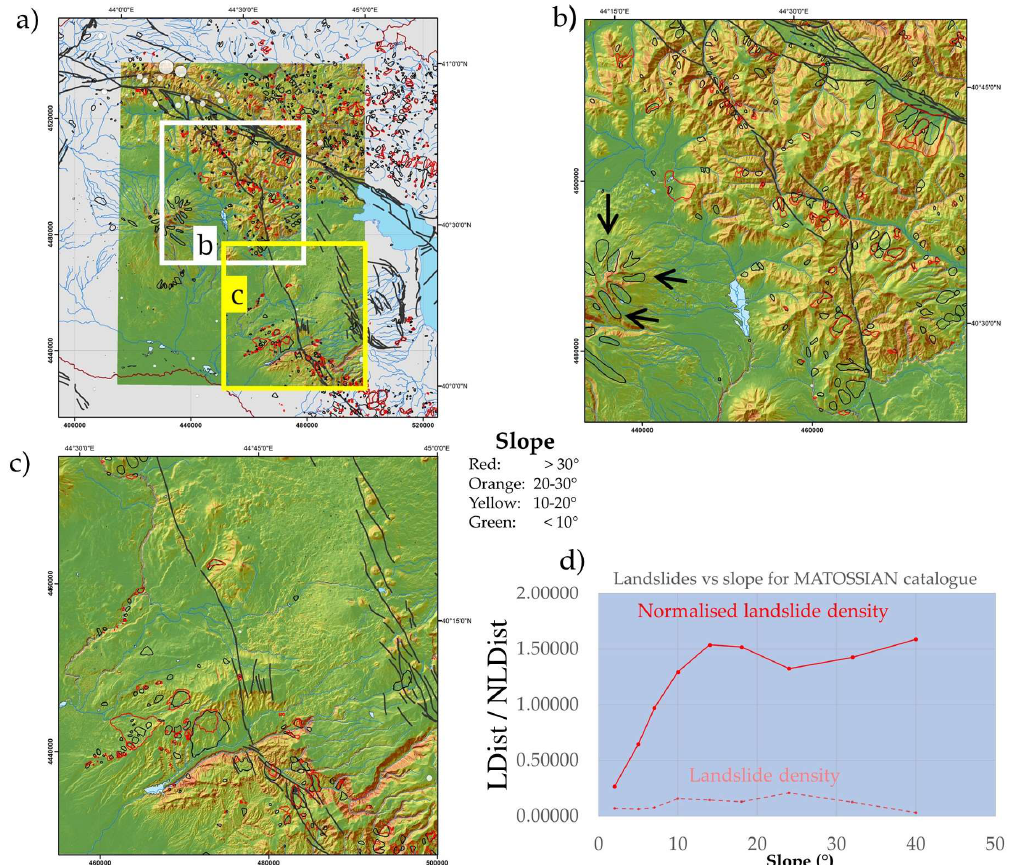
Figure 10. Landslide distribution with respect to local slope. ( a ) General map showing the locations of maps ( a ) and ( c ). ( b ) Enlarged view of the area to the east of Aragats volcano, showing the GF (west) and PSSF (east). Arrows mark zones atop Aragats where landslides recorded in the Georisk catalogue occur on very gentle slopes; these deposits are, instead, most likely of glacial origin. ( c ) Enlarged view of the area to the east of Yerevan, including part of the Ghegham volcanic ridge in the east. ( d ) Landslide density as a function of local slope. Landslide density represents the ratio of landslide areas within a certain slope class compared to the entire area covered by mass movements, whereas the normalized landslide density represents the same ratio normalized by the ratio of the class area divided by the total map area.